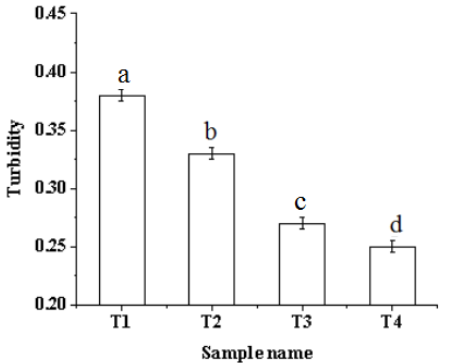
Figure 2. Effects of ultrasound-assisted sodium bicarbonate treatment on the turbidity of raw pork myofibrillar protein. T1, sodium bicarbonate 0 g, ultrasound time 0 min; T2, sodium bicarbonate 0.2 g, ultrasound time 0 min; T3, sodium bicarbonate 0.2 g, ultrasound time 30 min; T4, sodium bicarbonate 0.2 g, ultrasound time 60 min. Each value represents the mean ± SE, n = 4. a–d Different parameter superscripts indicate significant differences ( p < 0.05).